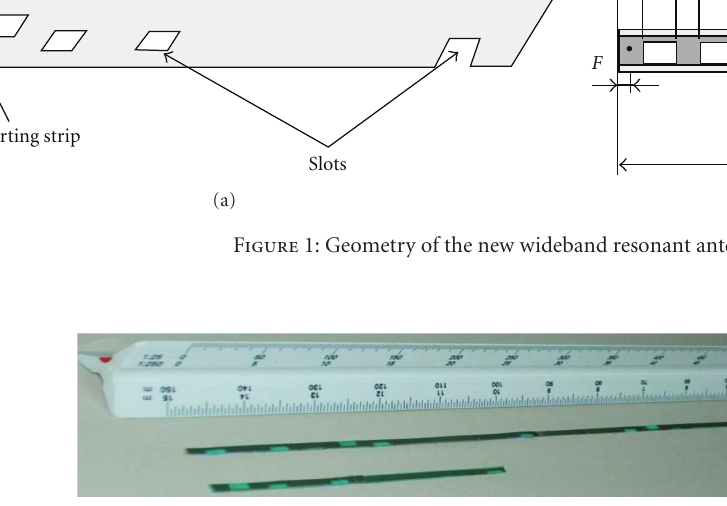
Figure 2: The antennas of the first dual antenna